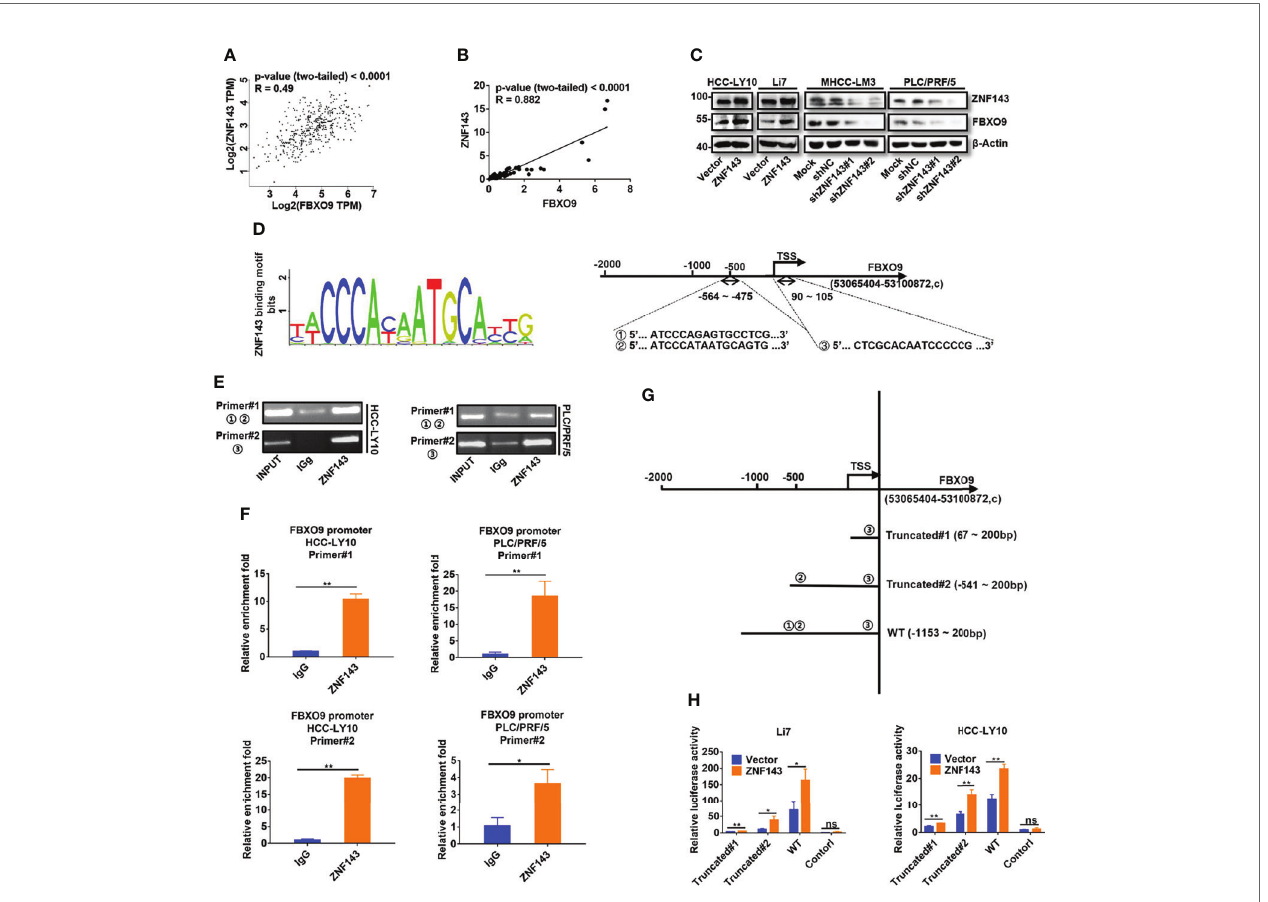
FIGURE 3 | ZNF143 binds to the FBXO9 promoter and promotes FBXO9 expression. (A) Veri fi cation of the correlation of ZNF143 and FBXO9 using the GEPIA database. (B) Scatter plots of the correlation between ZNF143 mRNA expression and FBXO9 mRNA expression in 64 HCC tissues from HCC patients. (C) The expression level of ZNF143 and FBXO9 as detected by western blotting in HCC cells after knockdown or overexpression of ZNF143. (D) Left, ZNF143 binding motif. Right, JASPAR analysis showed three potential ZNF143-binding sites of the promoter region of FBXO9. (E) Agarose gel electrophoresis for CHIP analysis of ZNF143 binding to the FBXO9 promoter in HCC-LY10 and PLC/PRF/5 cells. (F) CHIP-qPCR analysis of ZNF143 binding to the FBXO9 promoter in PLC/PRF/5 and HCC- LY10 cells. (G) Different luciferase reporter vectors containing truncation mutants of FBXO9 were constructed and transfected into Li7 and HCC-LY10 cells. (H) The corresponding luciferase activities were determined using dual-luciferase reporter assays. Error bars represent mean ± S.D, n = 3. R, Pearson correlation coef fi cient. *, P < 0.05; **, P < 0.01; ns, no signi fi cance by two-tailed Student ’ s t -test or one-way